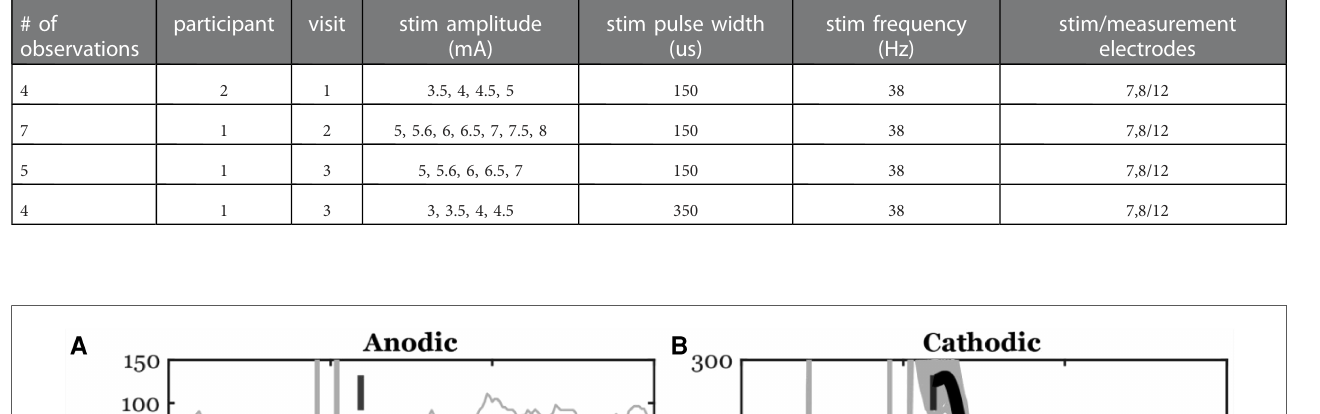
ECAP, respectively. Given that our time resolution is 31.25 µs (1/32 kHz), the average difference of N1 time in poly2 from exp2 is negligible. Exp2 had the best fi t to the stimulation artifact (R 2 in Figure 5 ) resulting in the ECAP with the cleanest morphology ( Figure 4 ). The average R 2 improvement of exp2 over exp1 and poly2 was 54.5% and 0.5% in anodic ECAP and 49.0% and 8.1% in cathodic ECAP,